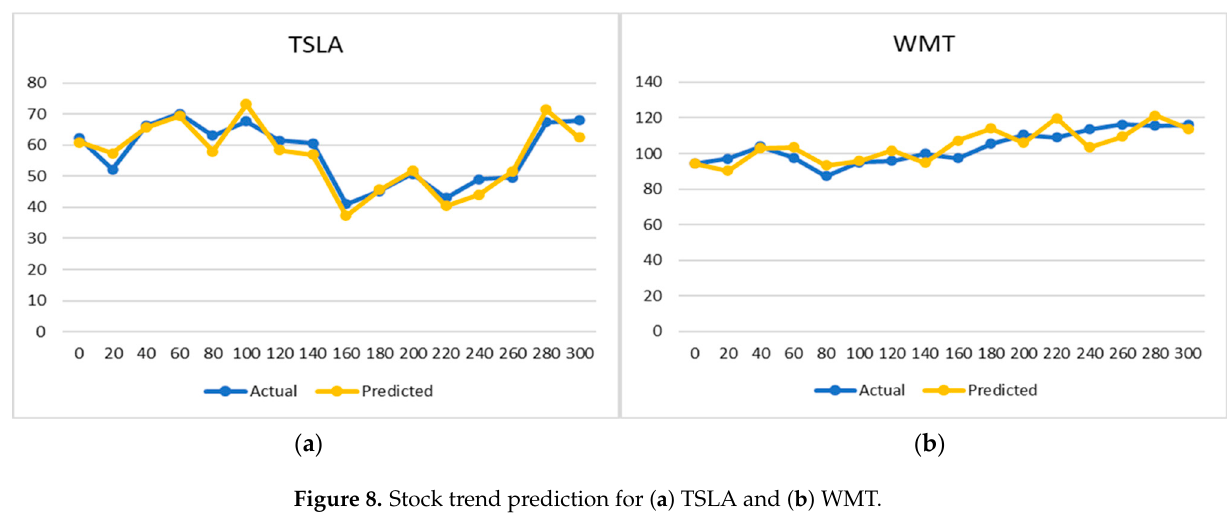
Figure 7. Future price estimation graph ( a ) MSFT and ( b ) GOOG.